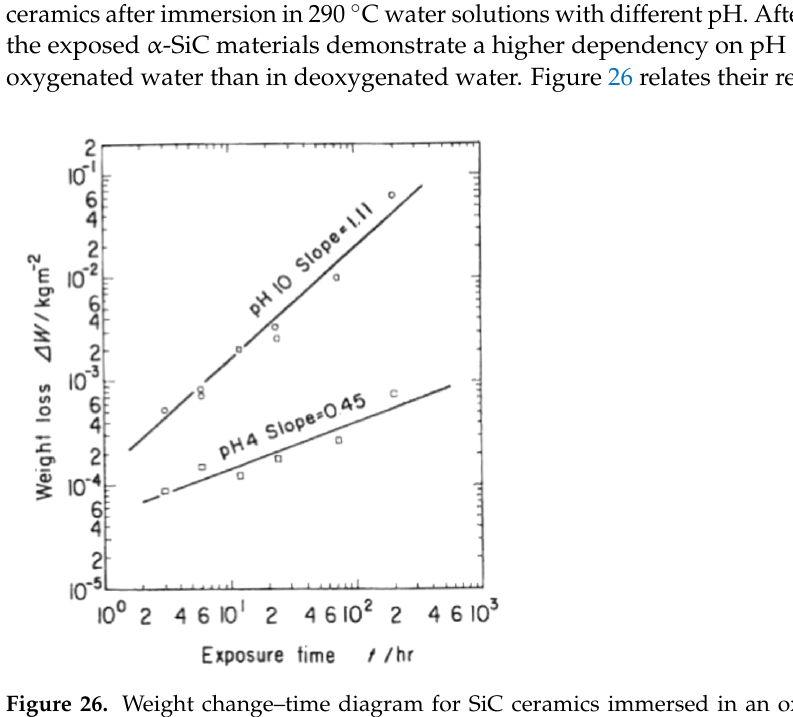
Figure 26. Weight change–time diagram for SiC ceramics immersed in an oxygenated solution (dissolved [O 2 ] is 32 ppm) at 290 °C. Reprinted with permission from Reference [93]. Copyright 1989 The American Ceramic Society/Wiley.